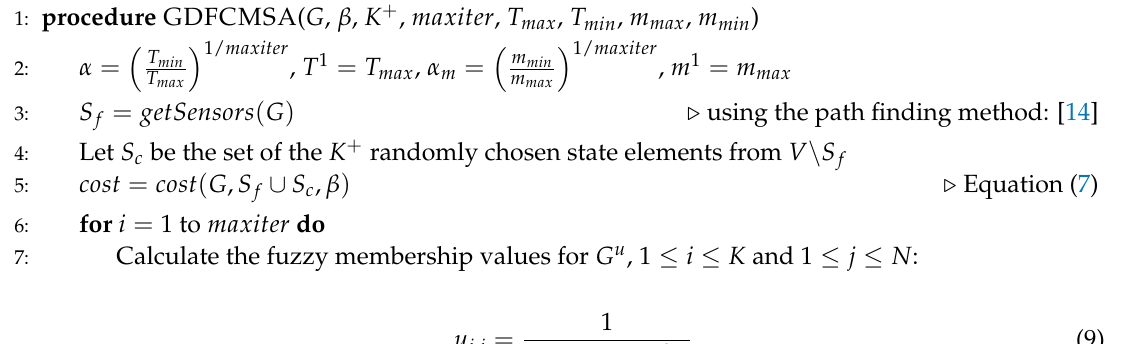
Algorithm 2 Pseudo code of the Geodesic Distance-based Fuzzy c -Medoid Clustering with Simulated Annealing algorithm